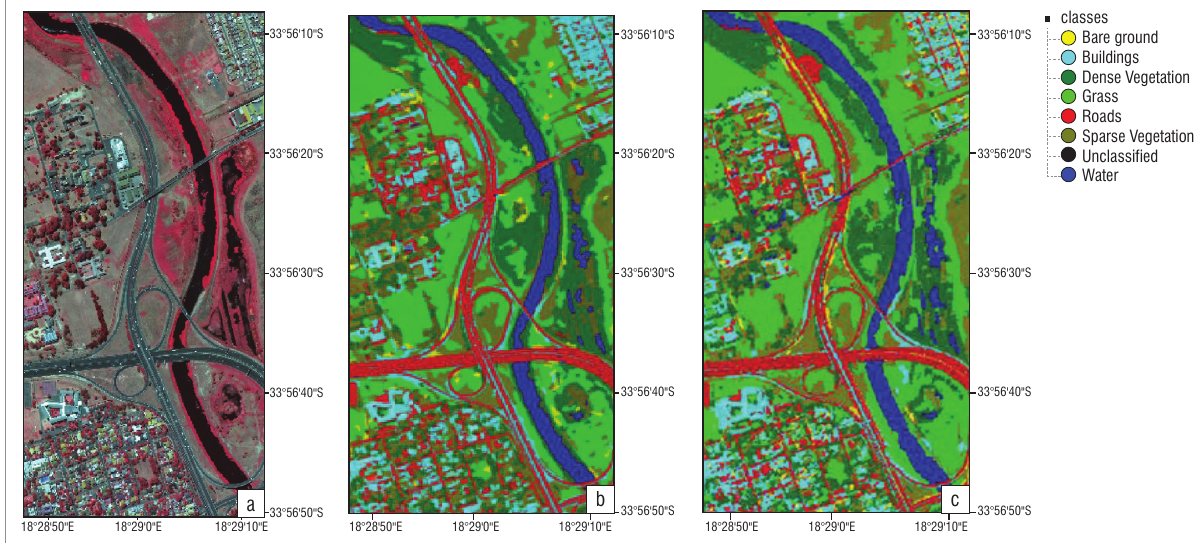
Figure 3: (a) A multispectral RGB 432 aerial photo composite, (b) a feature land-use/land-cover map using Haralick textural features and (c) a feature land- use/land-cover map using spectral